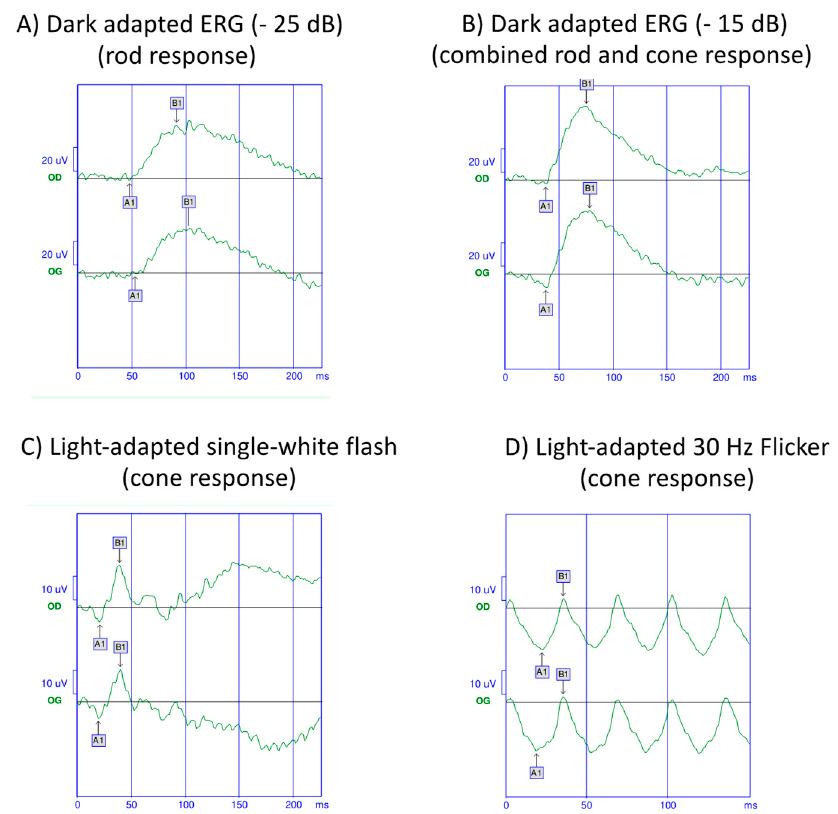
Figure 5. Global electroretinogram (ERG) of a 55-year-old man with birdshot chorioretinopathy. The rod-isolated ERG response ( A ) and combined rod cone response ( B ) are abnormal with a reduced amplitude of the a and b waves in both eyes. ( C , D ) The cones mediated responses are abnormal with a reduced amplitude and an increased delay.